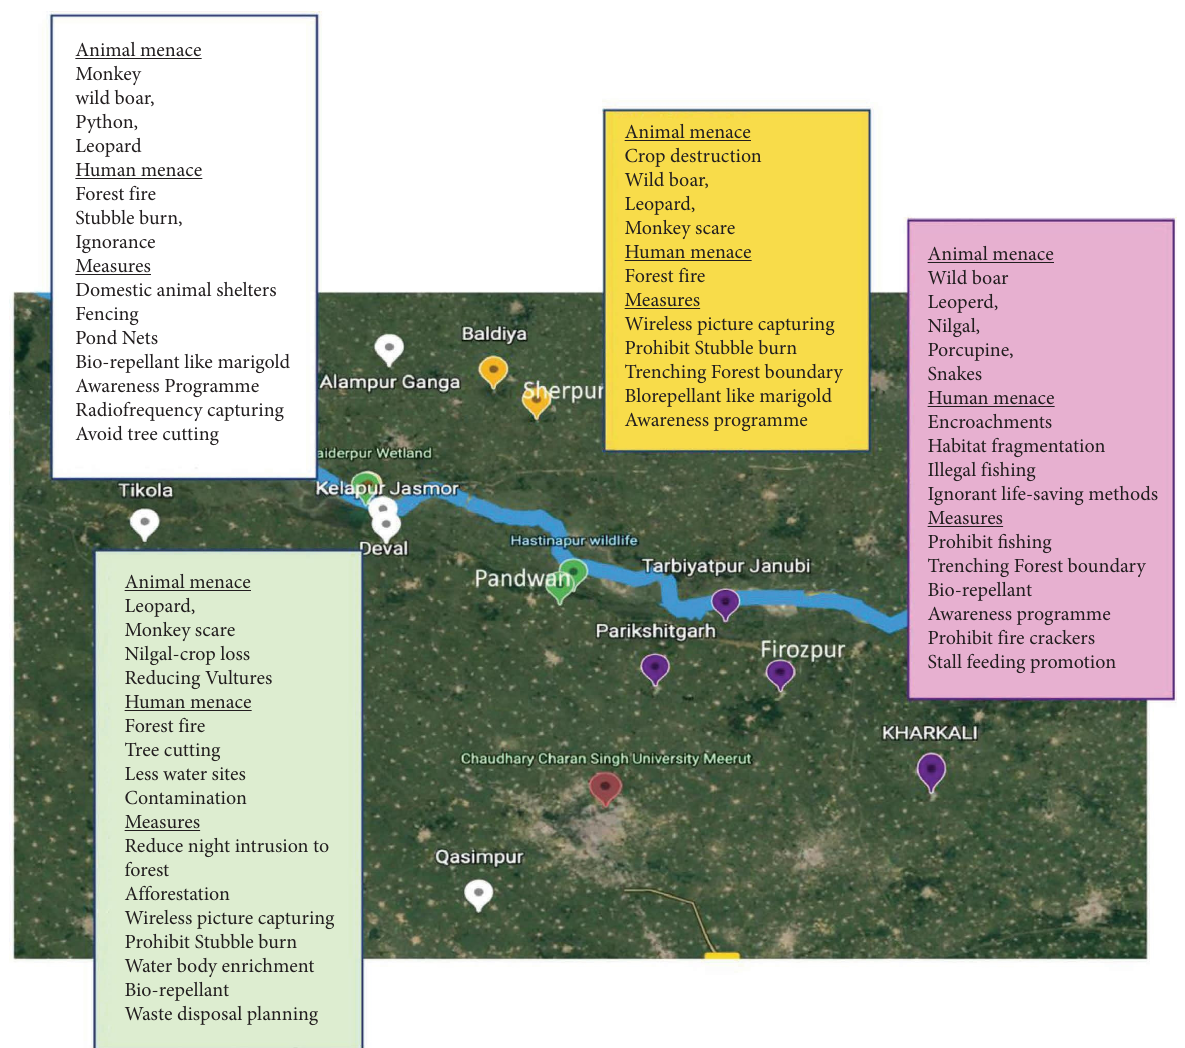
Figure 3: Map depicting human-wildlife confict in Hastinapur sanctuary—animals and human menace and measures suggested to reduce confict (color codes-same as Figure